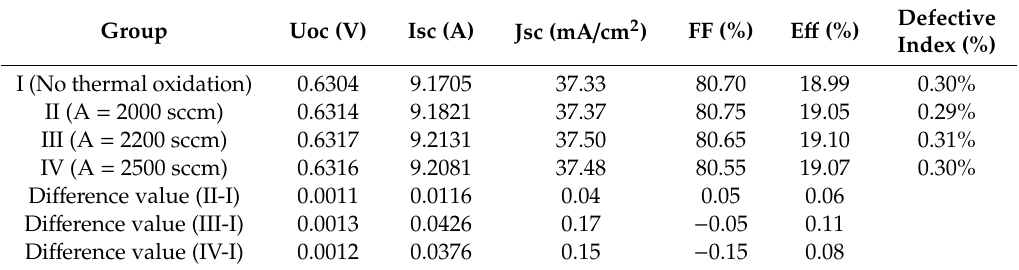
Table 5. The electrical performance results and di ff erences of the four